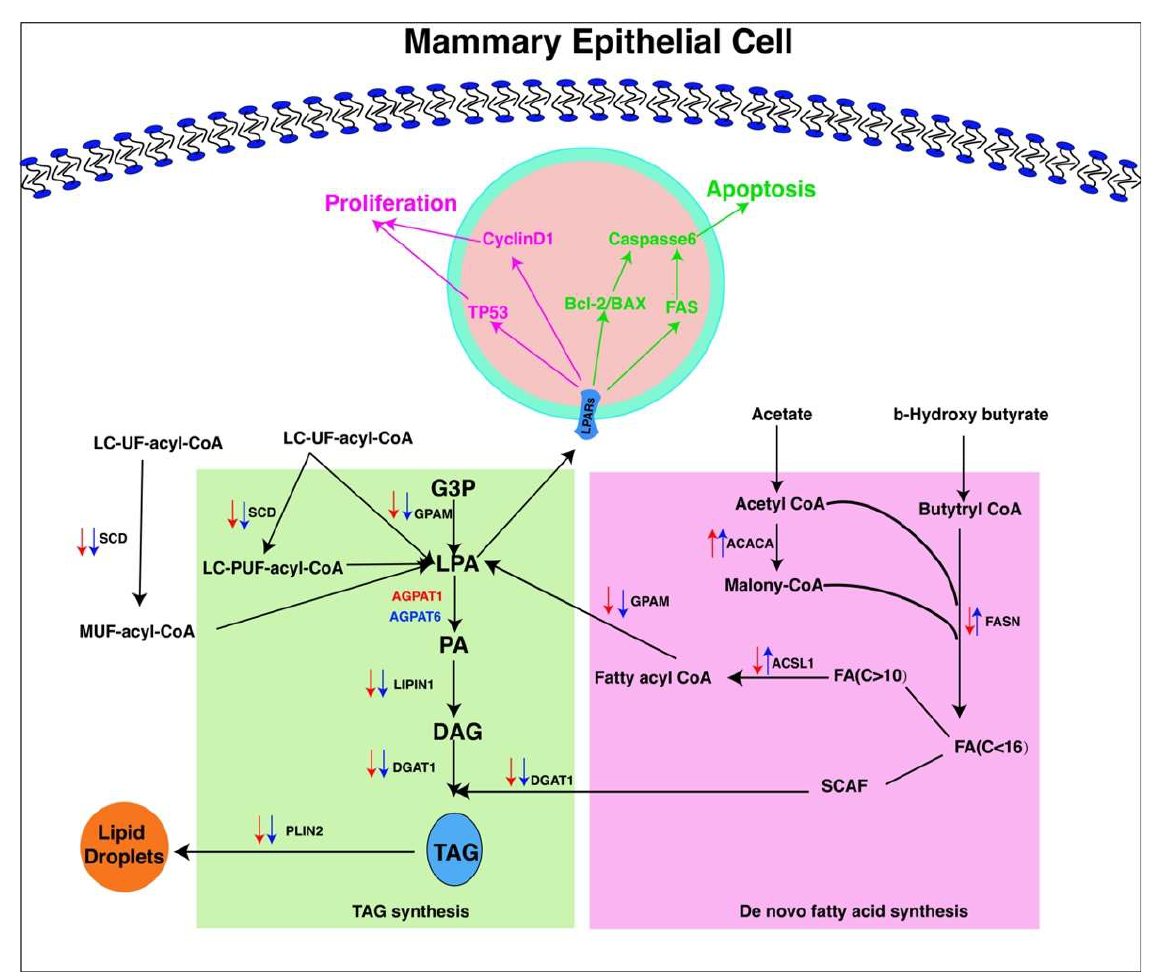
Figure 6. Schematic illustration for regulation mechanism of both AGPAT1 and AGPAT6 genes on TAG synthesis, apoptosis, and proliferation. Red arrow represents the expression of lipid metabo- lism related genes regulated by AGPAT1 ; blue arrow represents the expression of lipid metabolism related genes regulated by AGPAT6 ; purple font and arrows represent cell proliferation involving both AGPAT1 and AGPAT6 genes; Green font and arrows represent cell apoptosis involving both AGPAT1 and AGPAT6